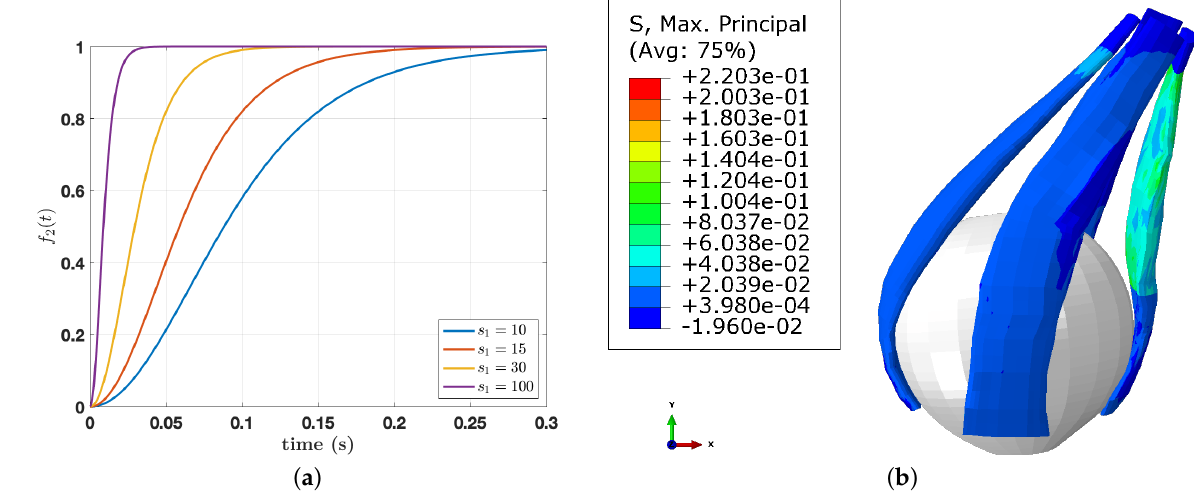
Figure 5. ( a ) Evolution of the activation function f 2 ( t ) with α = 1 for different s 1 parameter values simulating four contraction velocities; and ( b ) maximum principal stress distribution for the medial EOM activation with s 1 =